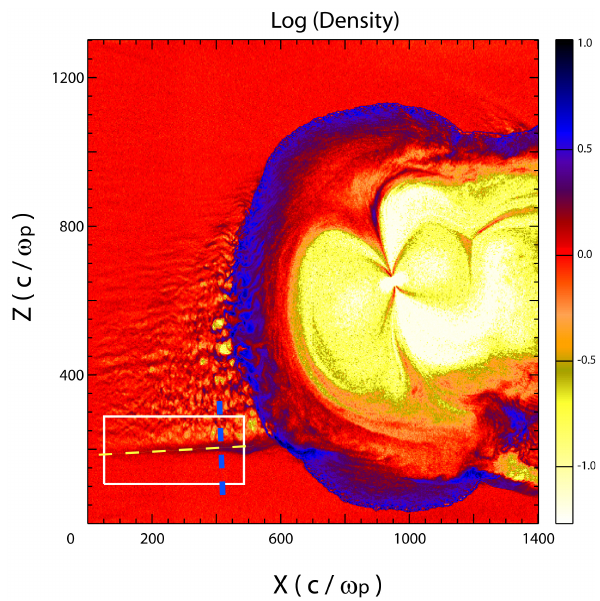
Fig. 1. Results from a hybrid code simulation in the noon-midnight meridional plane for the densities in the pristine solar wind, fore- shock, magnetosheath, and magnetosphere during an interval of ra- dial interplanetary magnetic field (IMF) orientation. The vertical line shows a cut across the sharp southern boundary of the fore- shock. The horizontal line shows a cut along the sharp southern boundary of the foreshock. A box encloses a region selected for further statistical analysis and comparison with